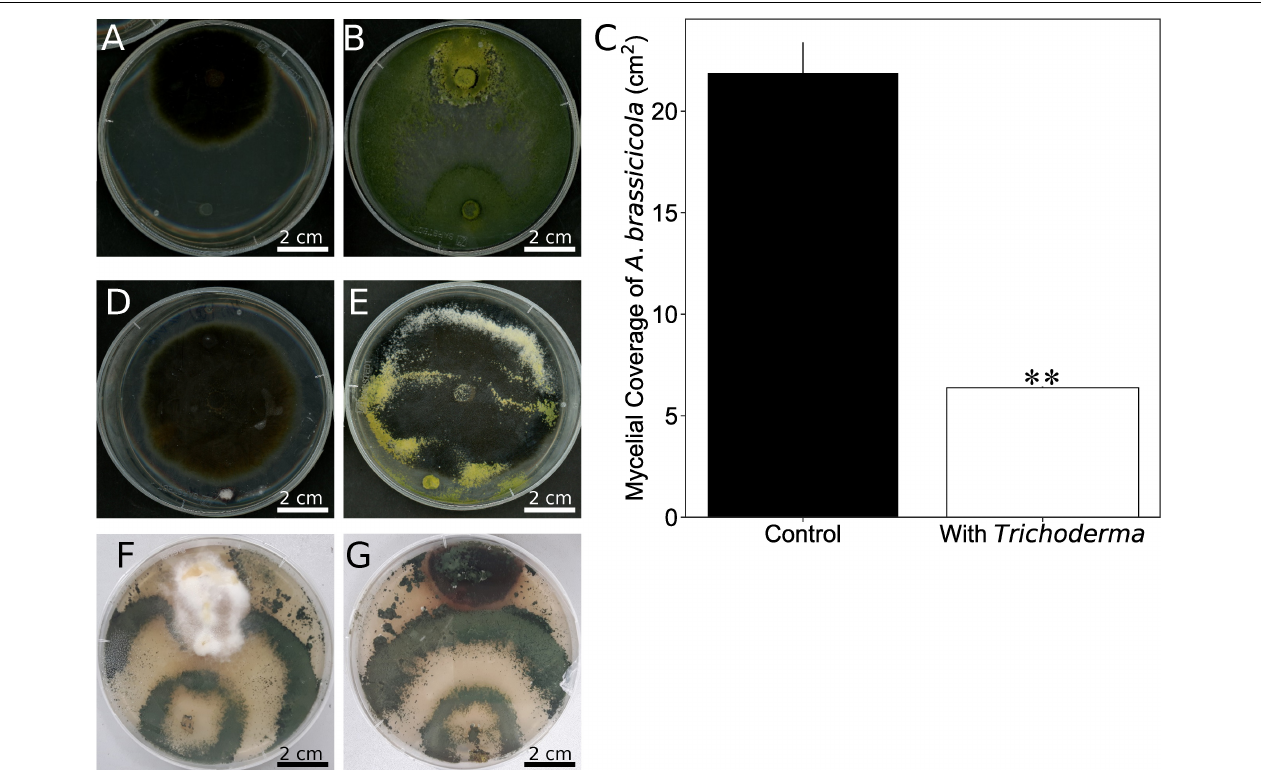
FIGURE 6 | Trichoderma inhibits growth of Alternaria brassicicola . (A,B) A plug of A. brassicicola was applied to the upper side of the PDA plate. A plug of KM agar (A) or the Trichoderma strain (B) was put to the lower side of the plate before co-cultivation for 8 days. (C) Quantification of A. brassicicola mycelial coverage from (A,B) . Error bars represent SDs from three independent biological replicates. Statistical significance was determined by Welch Two Sample t -test ( ∗∗ P < 0.01). (D) An agar plug with Trichoderma was placed on a PDA plate which contained 7-day old A. brassicicola culture. (E) Seven days after the plug with Trichoderma was placed in (D) . (F,G) Co-cultivation of Trichoderma with the native N. attenuata pathogens Fusarium brachygibbosum (F) or Alternaria spp. strain Utah 10 (G)